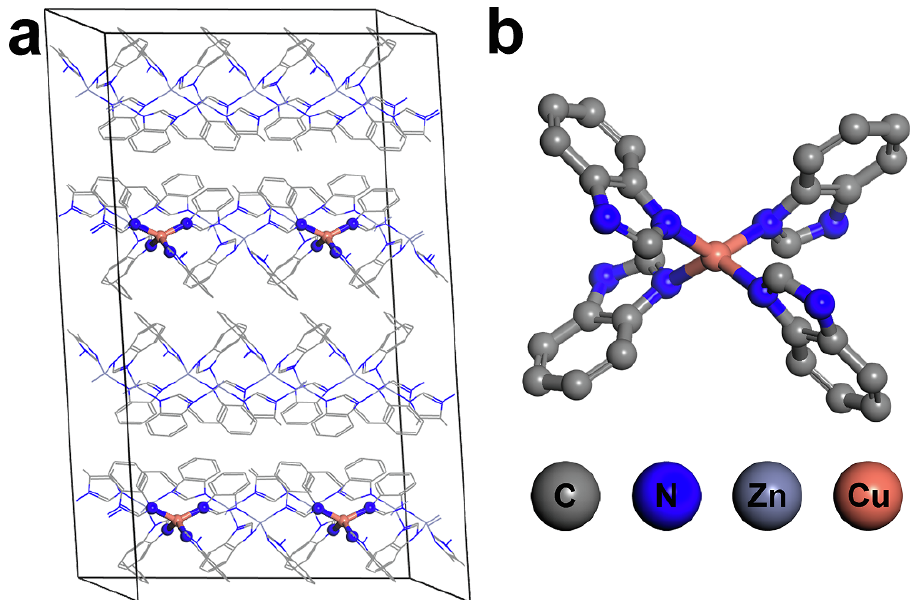
Figure 10. ( a ) Model system and ( b ) an element compound structure of Cu/ZIF-7. Reproduced with permission from ref [63]. Copyright 2022,